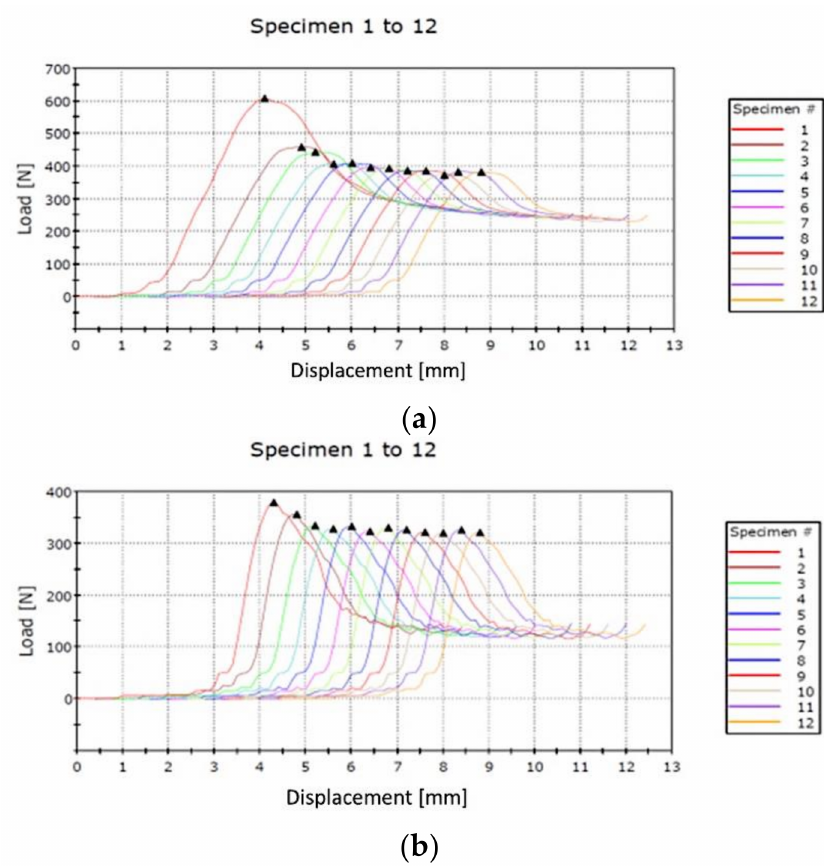
Figure 15. Closing force evaluation at environmental temperature for ( a ) Type I seal and ( b ) Type II seal (peak values highlighted by black triangles).